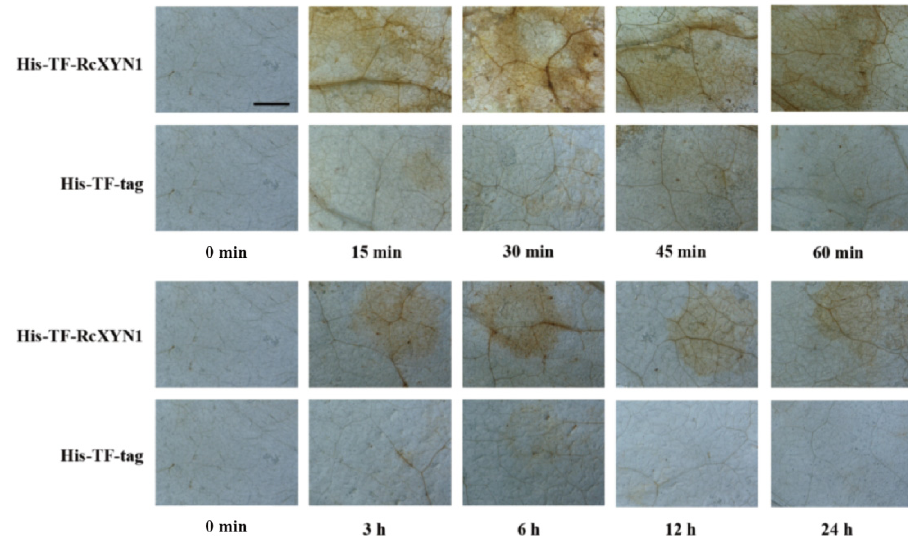
Figure 7. Microscopic observation of H 2 O 2 accumulation in RcXYN1-infiltrated N. benthamiana leaves. H 2 O 2 accumulation (as indicated by diaminobenzidine staining) appeared in the veins and stomata of His-TF-RcXYN1-infiltrated leaves but not in leaves treated with 5 µ M His-TF-tag solution. Bar, 2 mm.